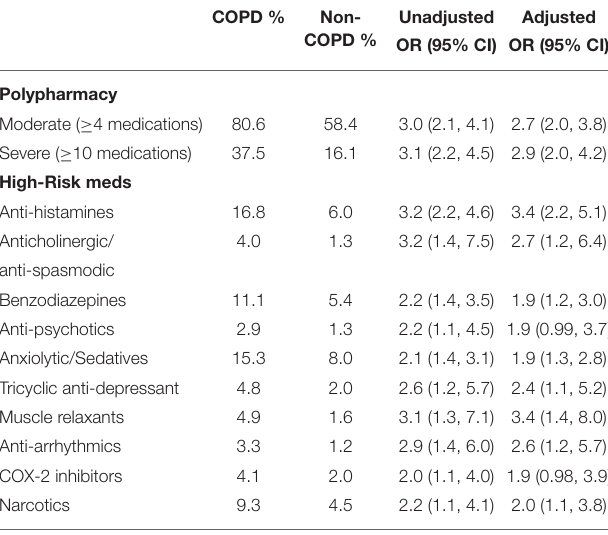
TABLE 4 | Polypharmacy and high-risk medications among US older adults with and without COPD by self-report. COPD % Non- Unadjusted Adjusted COPD % OR (95% CI) OR (95%